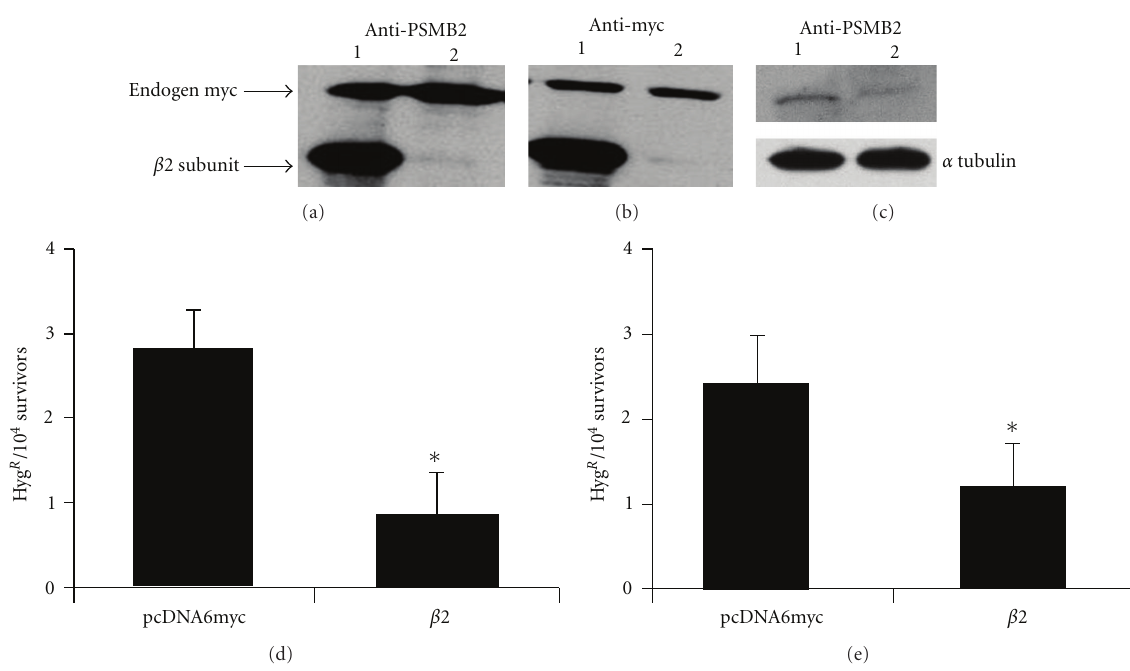
Figure 2: The over-expression of the β 2 subunit of proteasome decreases HR. To determine if the β 2 subunit was over-expressed in HeLaG1 cells, first we carried out Western blot analysis of total protein extracts 24 hours after transfection (a) and in the stably clonal population transfected with the β 2 plasmid (b) using the anti-myc as primary antibody to detect the myc-tagged β 2 subunit. The endogenous myc is indicated in (a) and (b) and is used as loading control. In (c), we carried out Western blot using the anti-PSMB2 ( β 2 subunit) as primary antibody. 30 μ g of total protein extract was loaded as follows: lane 1, total protein extract from cells transfected with the plasmid expressing the β 2 subunit; lane 2, total protein extract from cells transfected with the plasmid pcDNA6myc. Intrachromosomal HR was determined 24 hours after the transfection of the HeLa G1 with the plasmid expressing the β 2 subunit or with the empty pcDNA6myc (d); recombination was also measured in the cell population derived from HeLaG1 stably transfected with the plasmid expressing the β 2 subunit or with the empty pcDNA6myc (e). The frequency of HR was calculated by dividing the total number of HYG R colonies by the number of viable cells. Data are reported as mean of five independent experiments ± standard deviation. Results are statistically analyzed using Student t -test. ∗ P < . 005.